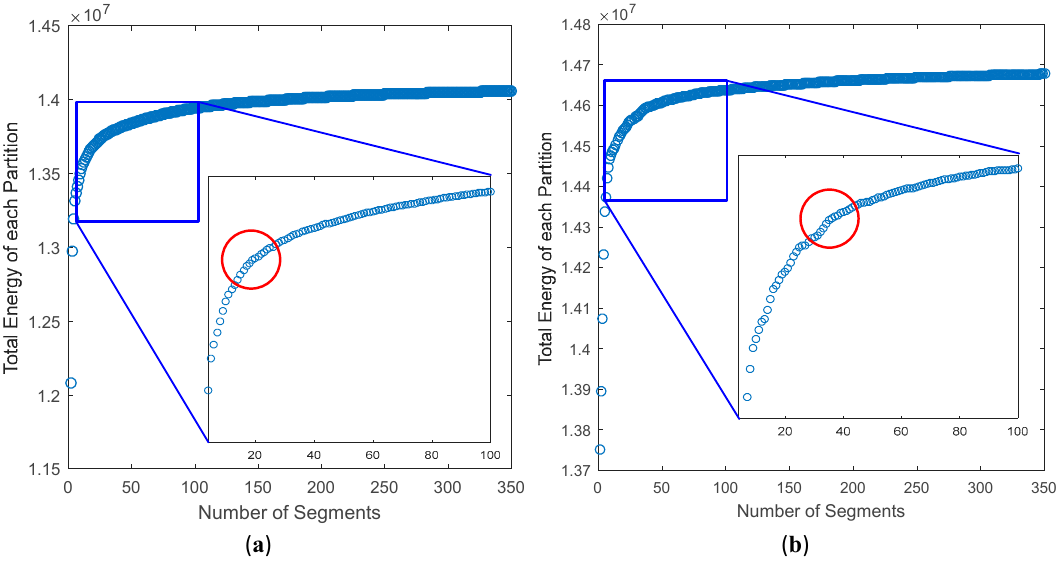
Figure 7. The energy function of the intermediate partitions based on the ( a ) Wishart criterion and ( b ) KummerU criterion.